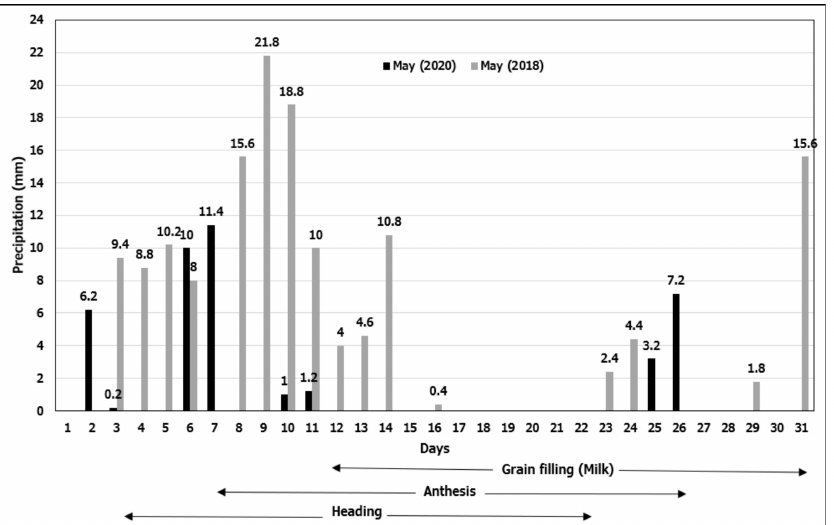
Figure 1. Daily precipitations recorded in May of both seasons, excluding June because of lack of precipitation (0.2 and 2.8 mm, respectively) (Table S3).